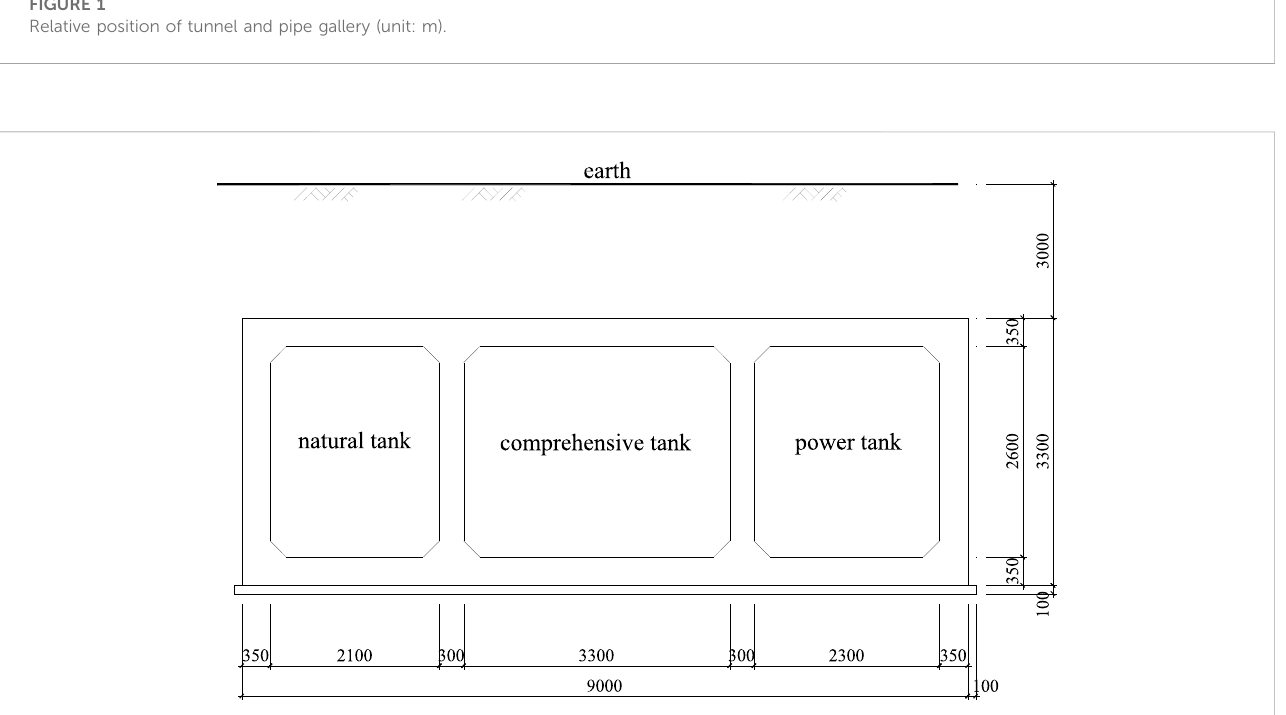
FIGURE 2 Dimensions of the underground pipe gallery (unit: